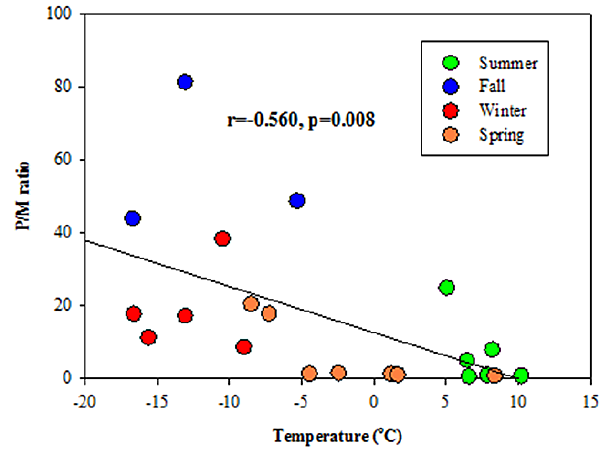
Figure 6. Negative correlation between P/M ratio and temperature.